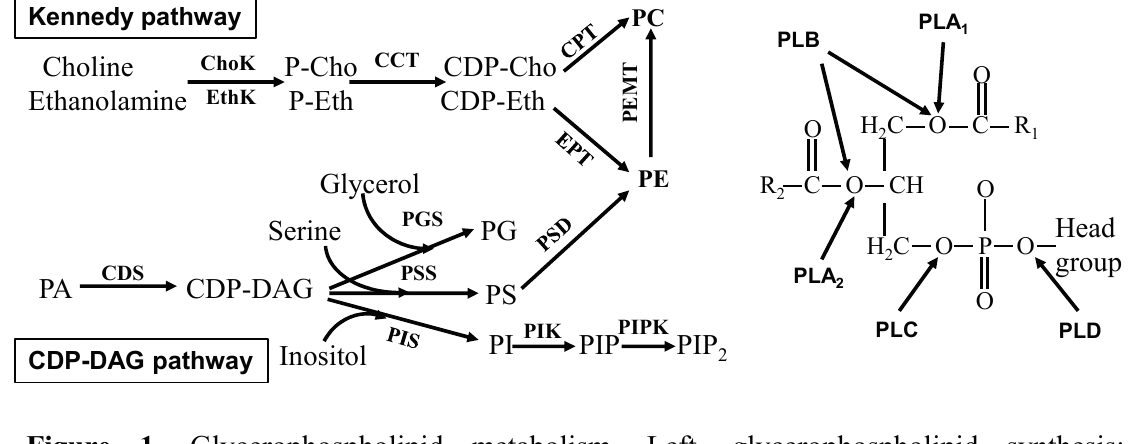
Figure 1. Glycerophospholipid metabolism. Left, glycerophospholipid